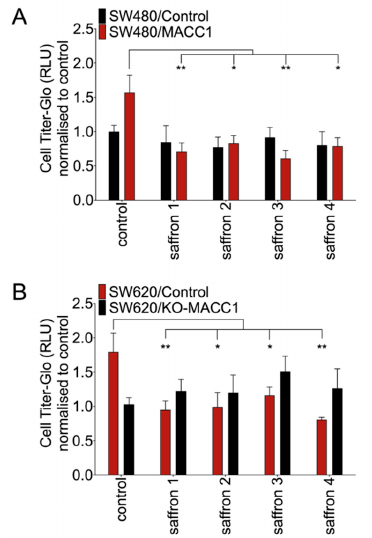
Figure 2. Saffron treatment reduced the migration of CRC cell lines. The low and high